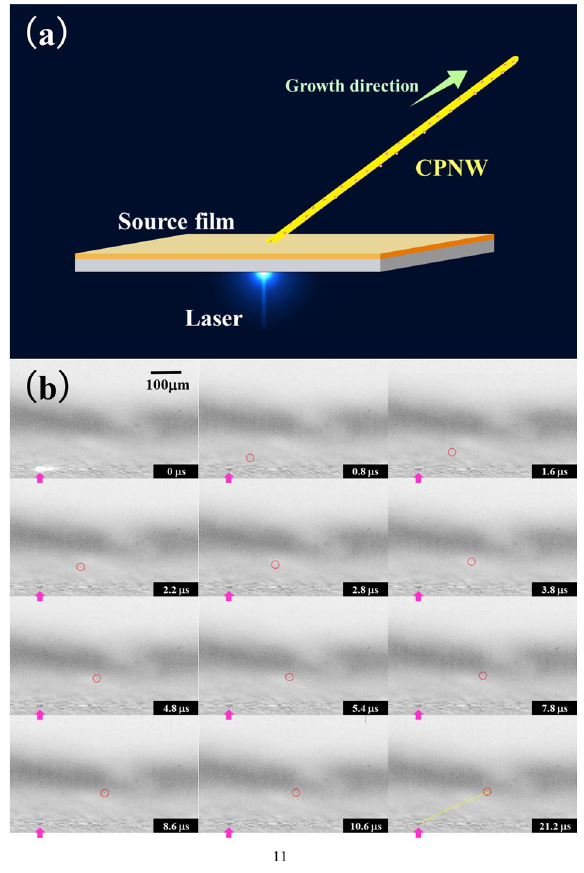
Figure 1. ( a ) Conductive polymer nanowire (CPNW) growth process via pulsed laser irradiation. The CPNW including quantum dots (QDs) is diagonally grown from the laser irradiation point on a source film. ( b ) Time- resolved shadowgraphy images of a PEDOT-PEG PNW including CdSe/ZnS core–shell QDs (QD-CPNW). The laser irradiation point and head of the CPNW are indicated by yellow and pink arrows,